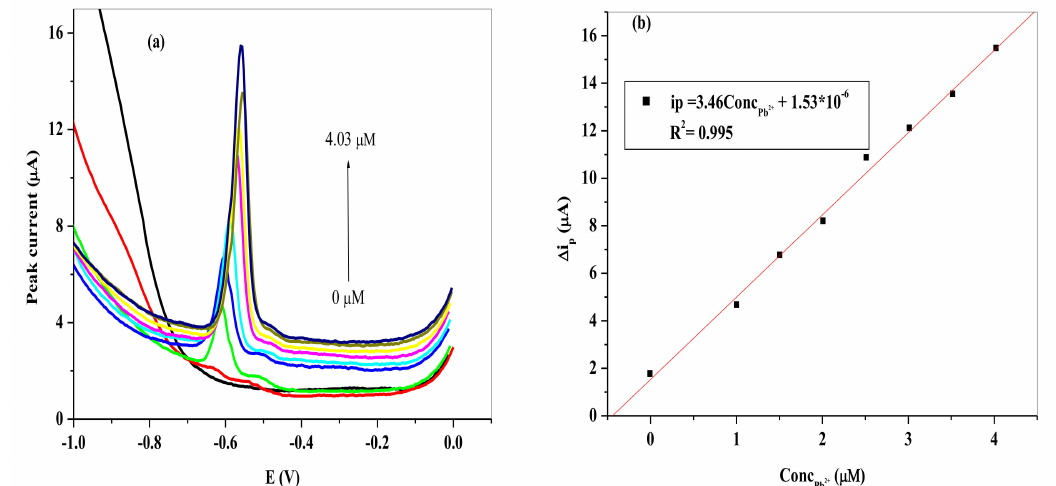
Figure 16. ( a ) SWVs of different concentrations of Pb 2+ on SPCE/OPE/BIONPs/PANI. ( b ) Calibration curves of the peak current vs. different concentrations of Pb 2+ . Potential vs. Ag/AgCl). Table 5 shows the comparison of the electrochemical performance of carbon-based elec- trodes in the detection of Pb 2+ , and demonstrates the applicability of the SPCE/LPE/BIONPs/ PANI and SPCE/OPE/BIONPs/PANI in environmental monitoring of Pb 2+ in water. The comparison of LODs and LOQs of the Pb 2+ analytes at the SPCE/LPE/BiONPs/PANI and SPCE/OPE/BiONPs/PANI, with other reported modified electrodes, given optimum conditions. Potential vs. Ag/AgCl. Electrodes Sensitivity ( µ A/ µ M) STD. DEV. LOD (ppb) LOQ (ppb) Linear Range ( µ M) Method Analysis Deposition Time (s)